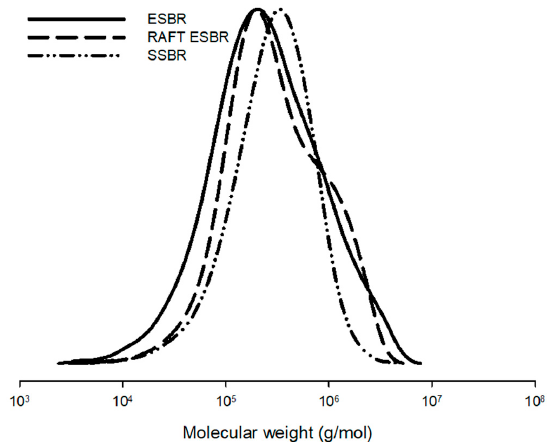
Figure 2. Gel permeation chromatography (GPC) curves of emulsion styrene butadiene rubber (ESBR), reversible addition ‐ fragmentation radical transfer ESBR (RAFT ESBR), and solution styrene butadiene rubber (SSBR).